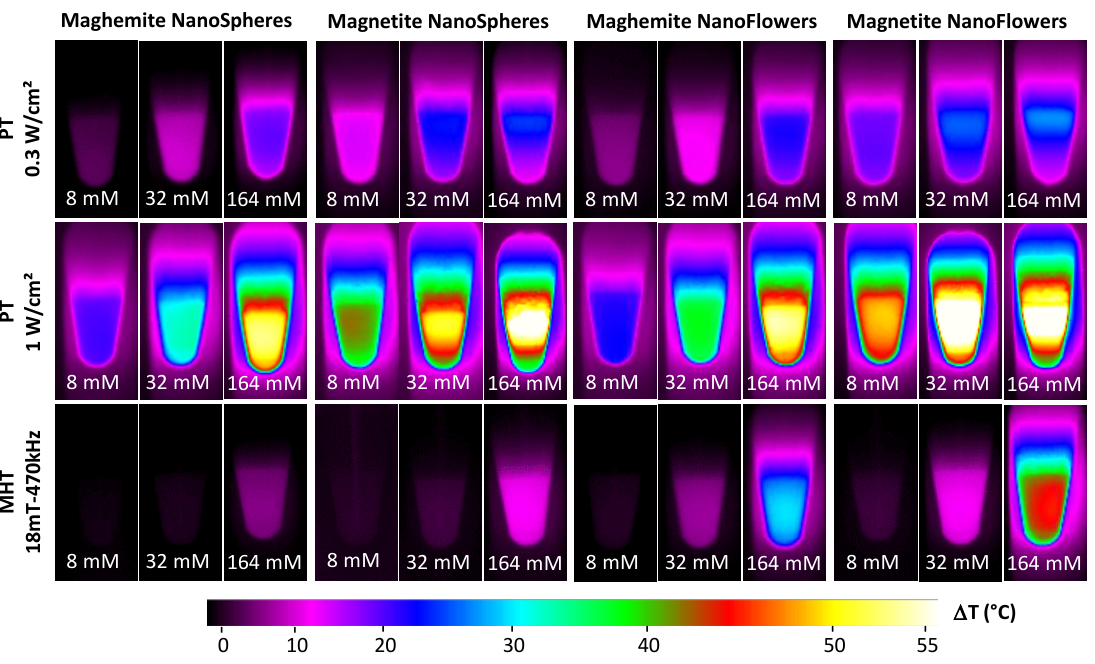
Figure 2. Heating measurements upon photothermal (PT) therapy at 0.3 and 1 W cm − 2 and magnetic hyperthermia (MHT) at 18 mT and 470 kHz. Representative infrared images of 50 µ L of four MNP preparations at Fe concentrations of 8, 32, and 164 mM after 10 min of exposure to the di ff erent external stimuli are displayed. Increases in temperature were analyzed for a 1064 nm laser at the power of 0.3 W cm − 2 ( top row ), 1 W cm − 2 ( middle row ), and alternating magnetic fields at 18 mT and 470 kHz ( bottom row ).